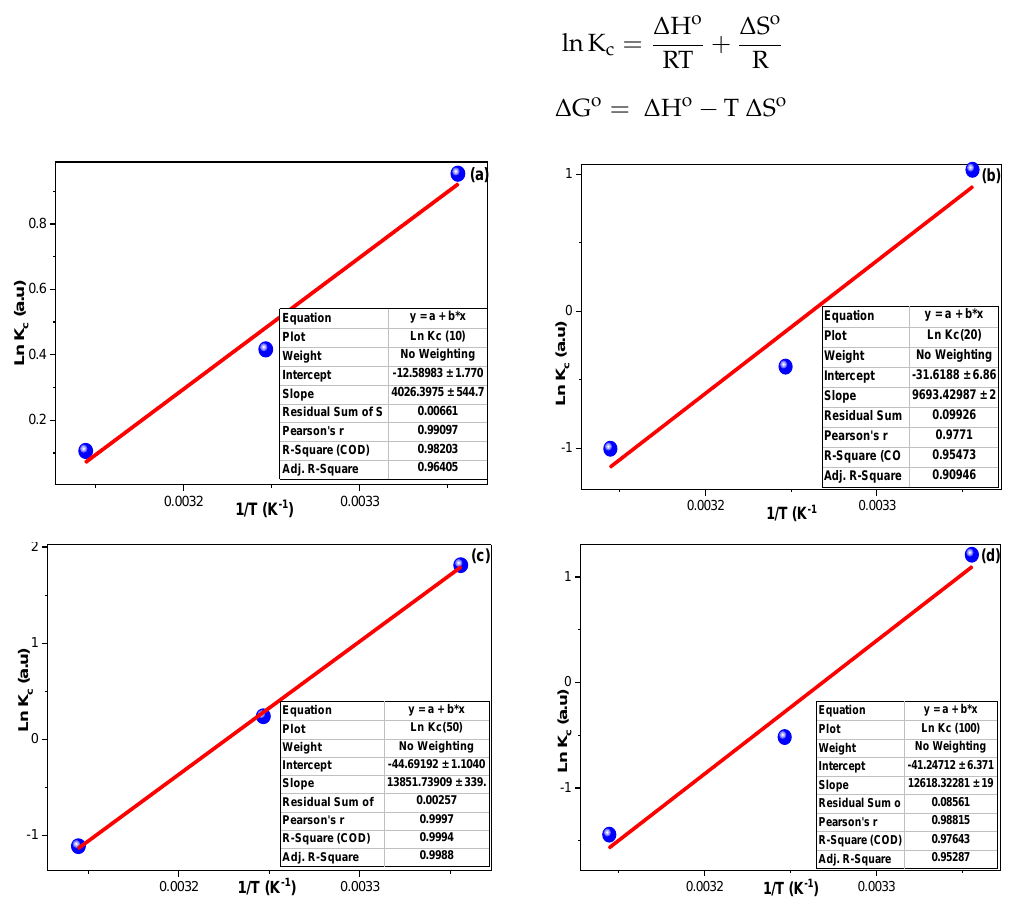
Figure 8. The thermodynamic investigation for IC adsorption on BiOI at 25 °C, 35 °C, and 45 °C for ( a ) 10, ( b ) 20, ( c ) 50, and ( d ) 100 mg L −1 solutions.